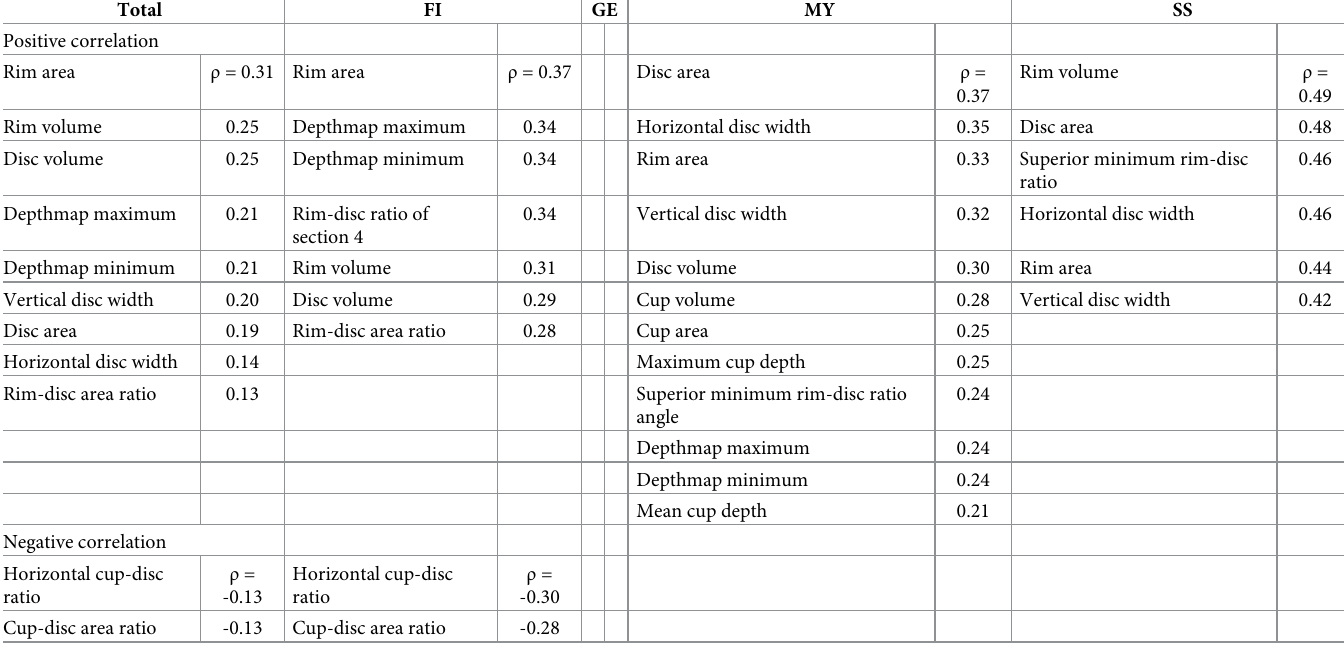
Table 6. Parameters significantly correlated with CRVE (sorted by effect size).